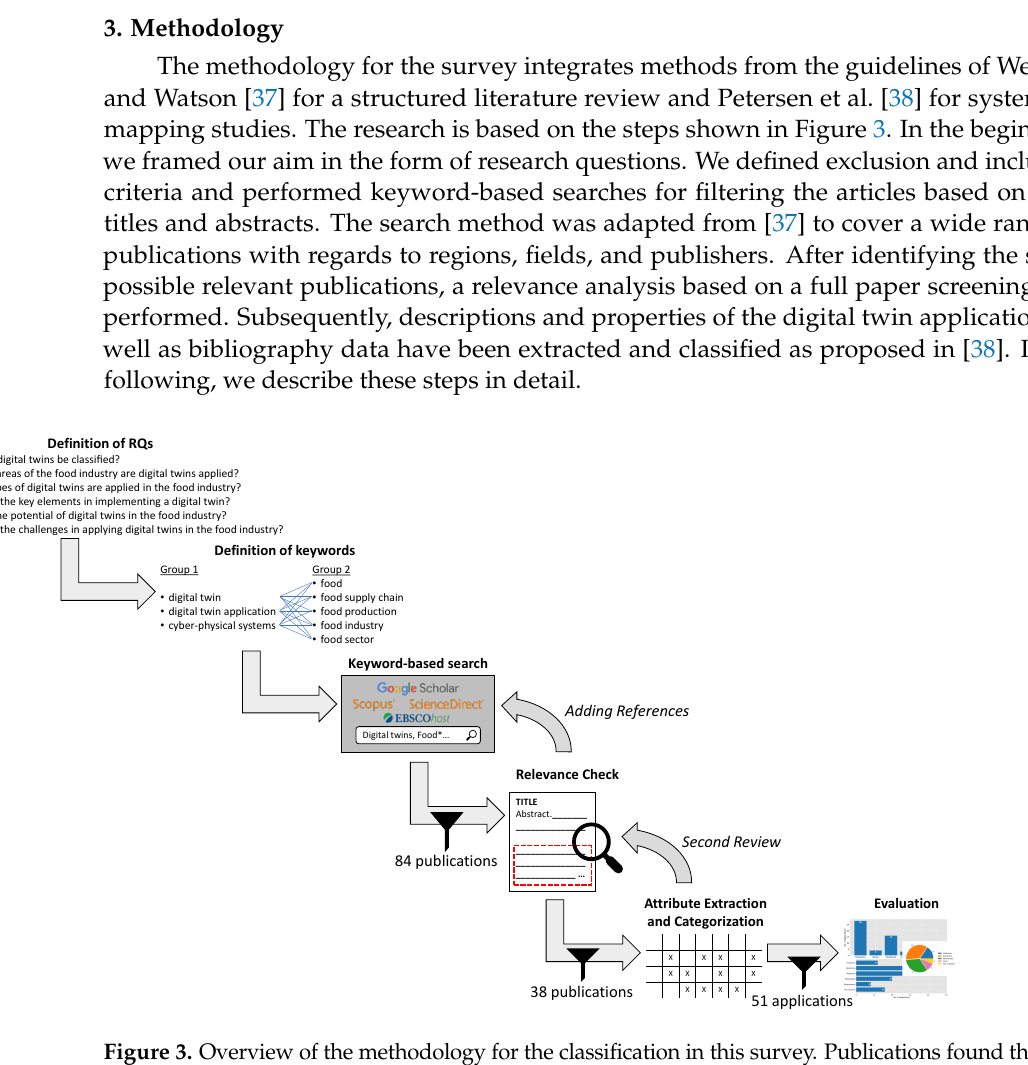
Figure 2. Digital (food) twin basic framework within the context of dairy processing.